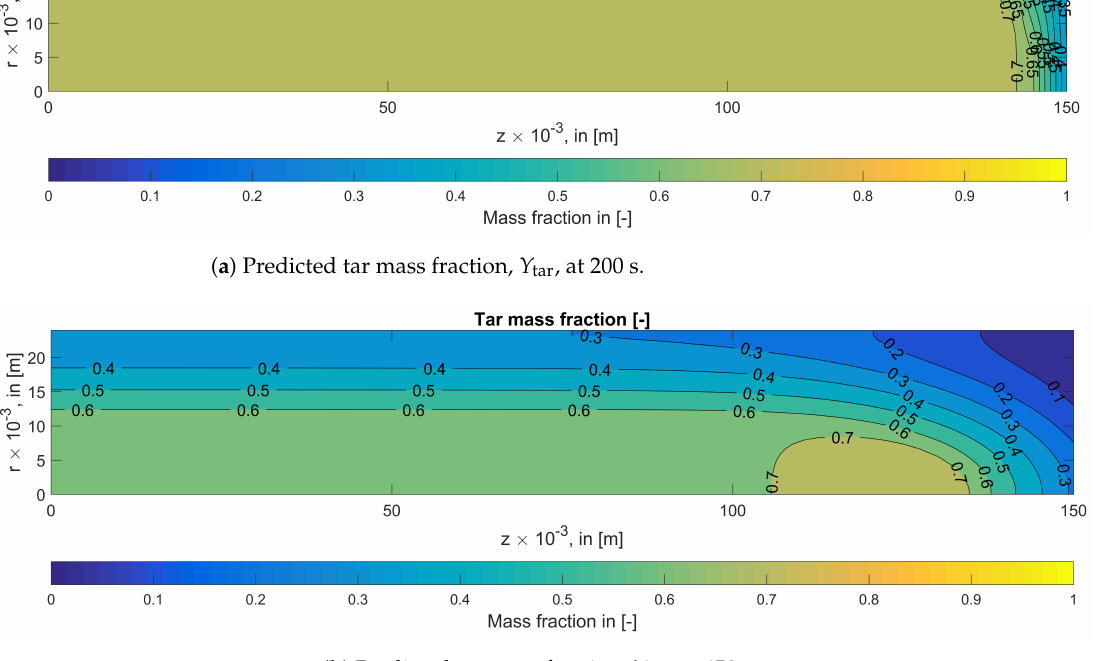
Figure 8. Tar mass fractions [-] at different times during devolatilization. The top of the wood log is at z = 150 mm, and the lateral surface of the wood log is at r = 25